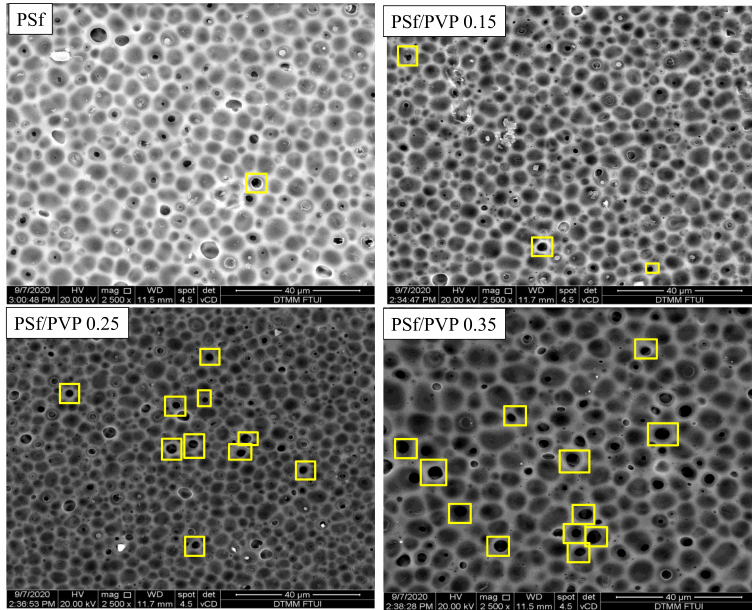
Figure 2. FESEM characterization of the surfaces of PSf, PSf/PVP 0.15, PSf/PVP 0.25, and PSf/PVP 0.35 membranes with a magnification of 2500 times.